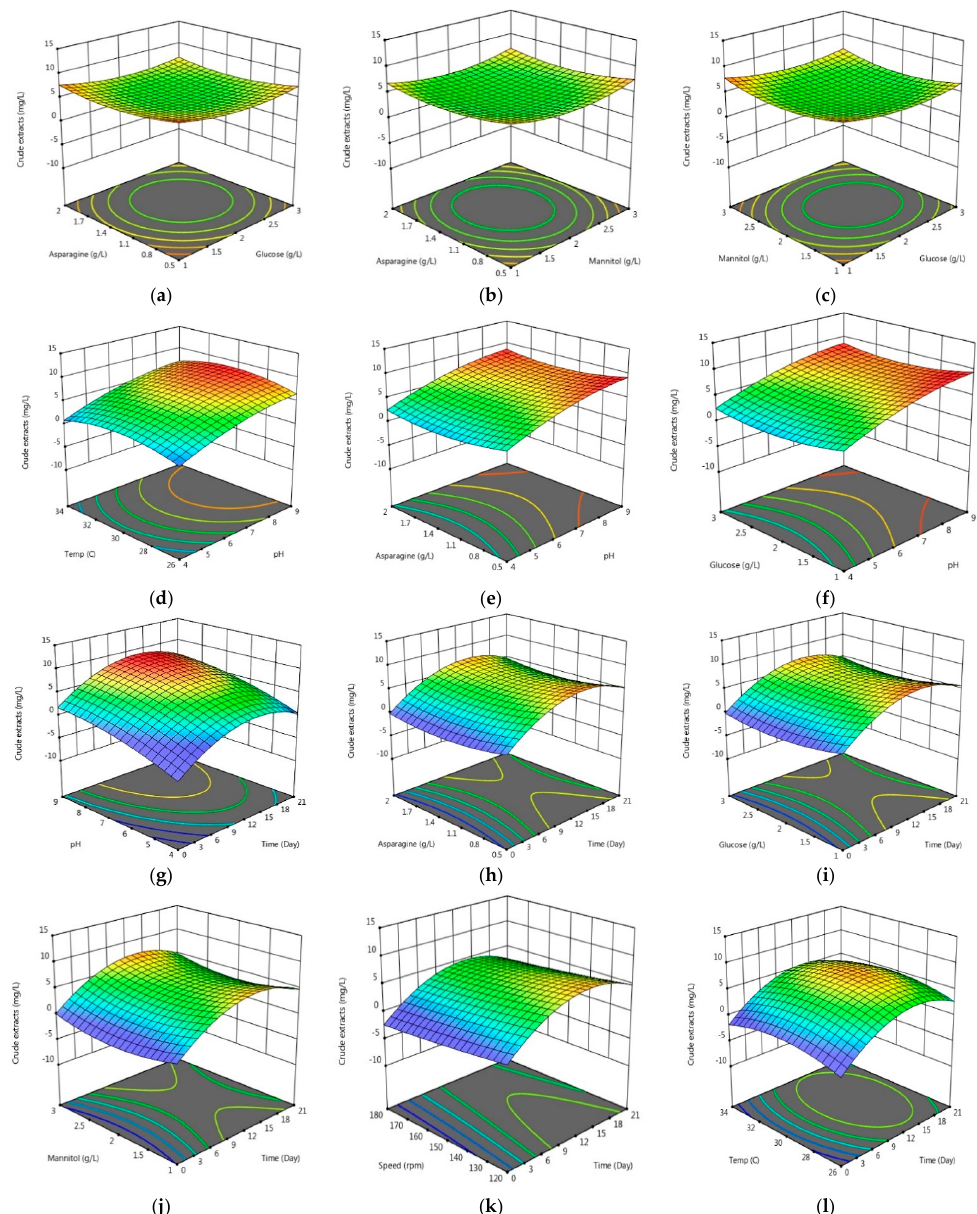
Figure 1. Three-dimensional response surface plot for interactions between 𝒙 𝟏 (time) (day), 𝒙 𝟐 (pH), 𝒙 𝟑 (temperature) (°C), 𝒙 𝟒 (speed) (rpm), 𝒙 𝟓 (glucose) (g/L), 𝒙 𝟔 (mannitol) (g/L), 𝒙 𝟕 (asparagine) (g/L), and their effects on 𝒚 𝟏 (crude ex- tracts) (mg/L). ( a ) Effects of asparagine and glucose on weight of crude extract; ( b ) Effects of asparagine and mannitol on weight of crude extract; ( c ) Effects of mannitol and glucose on weight of crude extract; ( d ) Effects of temperature and pH on the weight of crude extract; ( e ) Effects of asparagine and pH on weight of crude extract; ( f ) Effects of glucose and pH on the weight of crude extract; ( g ) Effects of pH and time on the weight of crude extract; ( h ) Effects of asparagine and time on the weight of crude extract; ( i ) Effects of glucose and time on the weight of crude extract; ( j ) Effects of mannitol and time on the weight of crude extract; ( k ) Effects of speed and time on the weight of crude extract; ( l ) Effects of temperature and time on the weight of crude